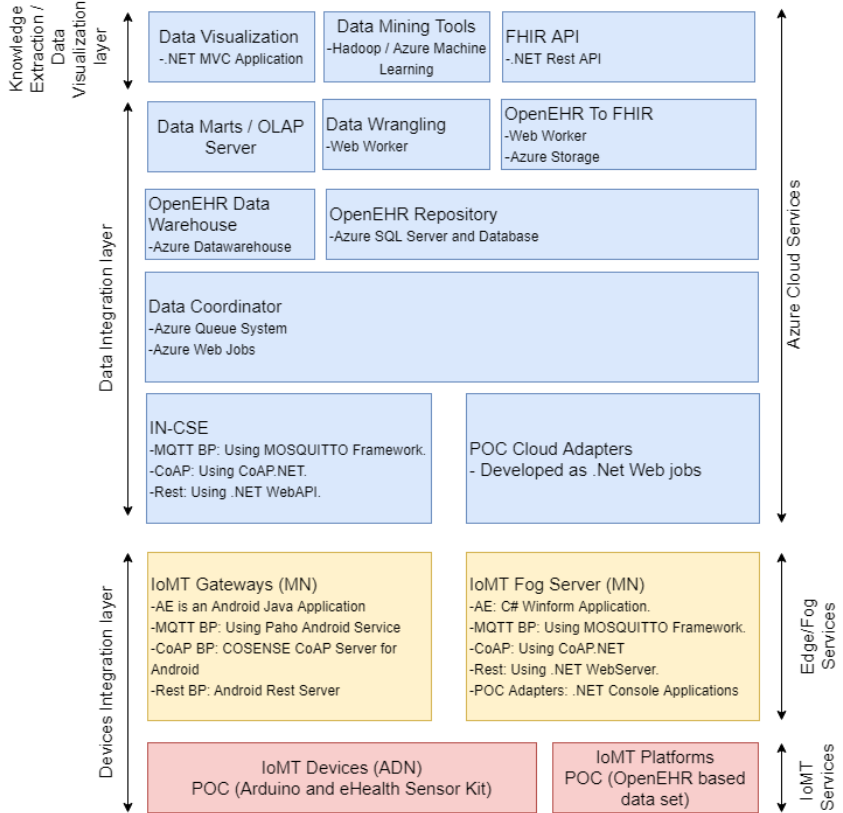
Figure 5. Technologies involved in platform implementation.